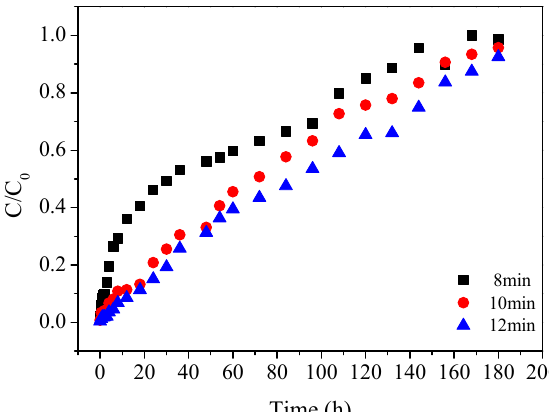
Figure 9. The breakthrough curve for varying residence time (min) at a bed depth of 20 cm and inlet Cu(II) concentration of 0.5 mg/L.